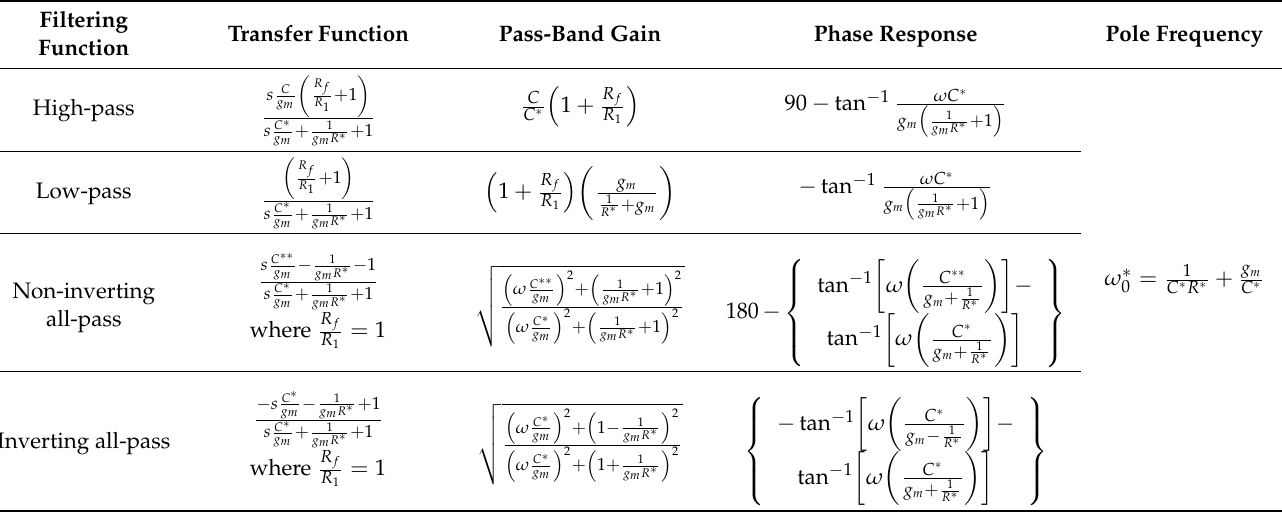
Table 3. The filtering parameters with parasitic